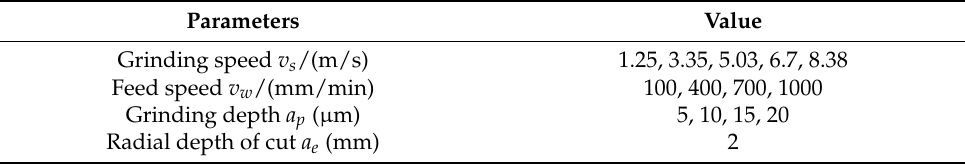
Table 2. Parameters of the grinding process.